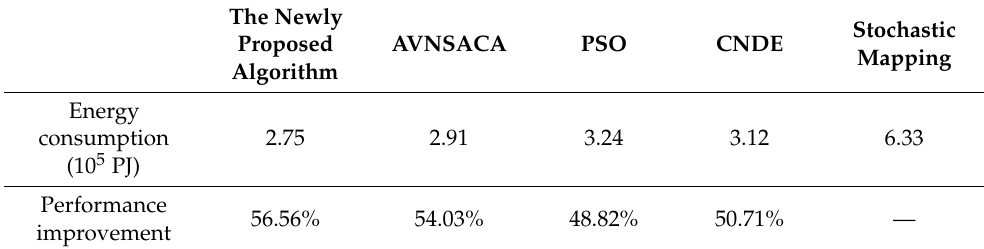
Table 2. Simulation results of different algorithms for